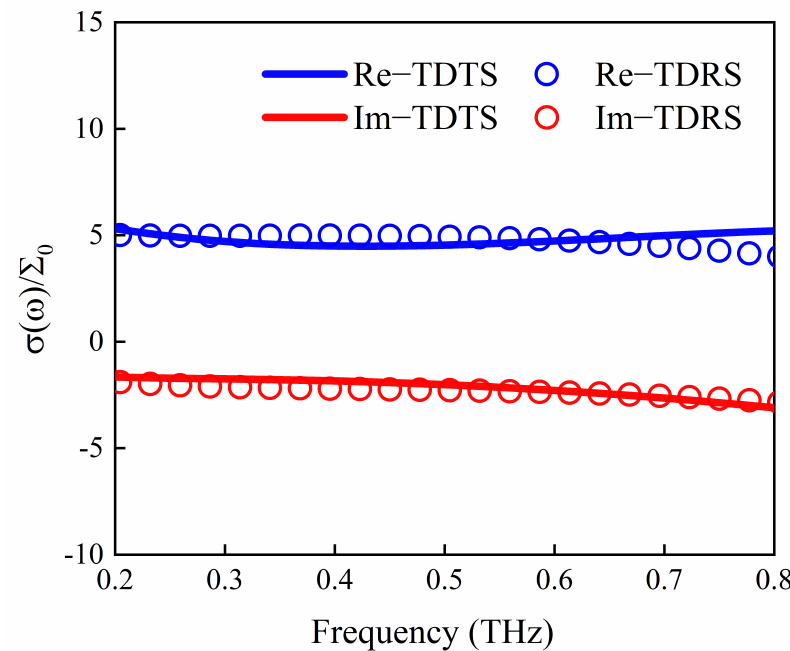
Figure 4. The optical conductivity of ML MoS 2 extracted from the TDRS and TDTS at normal incidence. Note that the optical conductivity is normalized by the universal conductivity Σ 0 = e 2 /4 (cid:125) = 6.07 × 10 − 5 S .